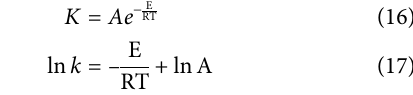
TABLE 3 | Results of Validation experiment. Experimental